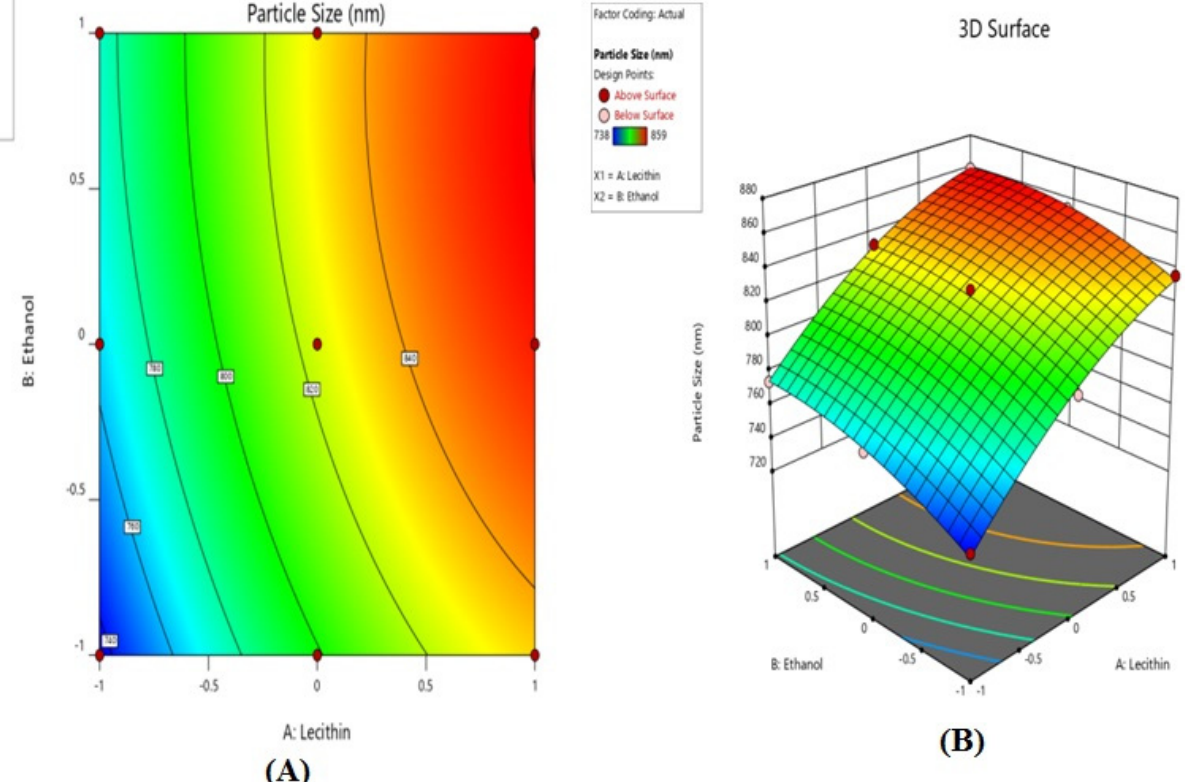
Figure 1. 2D contour plots ( A ) and 3D response surface plots ( B ) for evaluating the influence of lecithin ( X 1) and ethanol ( X 2) on particle size ( Y 1).